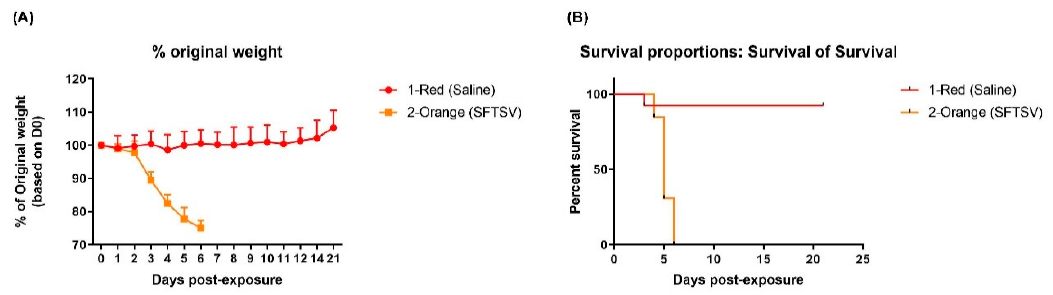
Figure 6. SFTSV lethality in interferon ( α / β ) receptor knockout (IFNAR - / - ) mice. ( A ) Weight curve from the SFTSV-infected (orange) and control (red) mice. ( B ) Survival curves for mice exposed to SFTSV (orange, experimental group) versus inoculated with saline solution (red, control group). Thirteen animals per group (6 male and 7 female) were used.